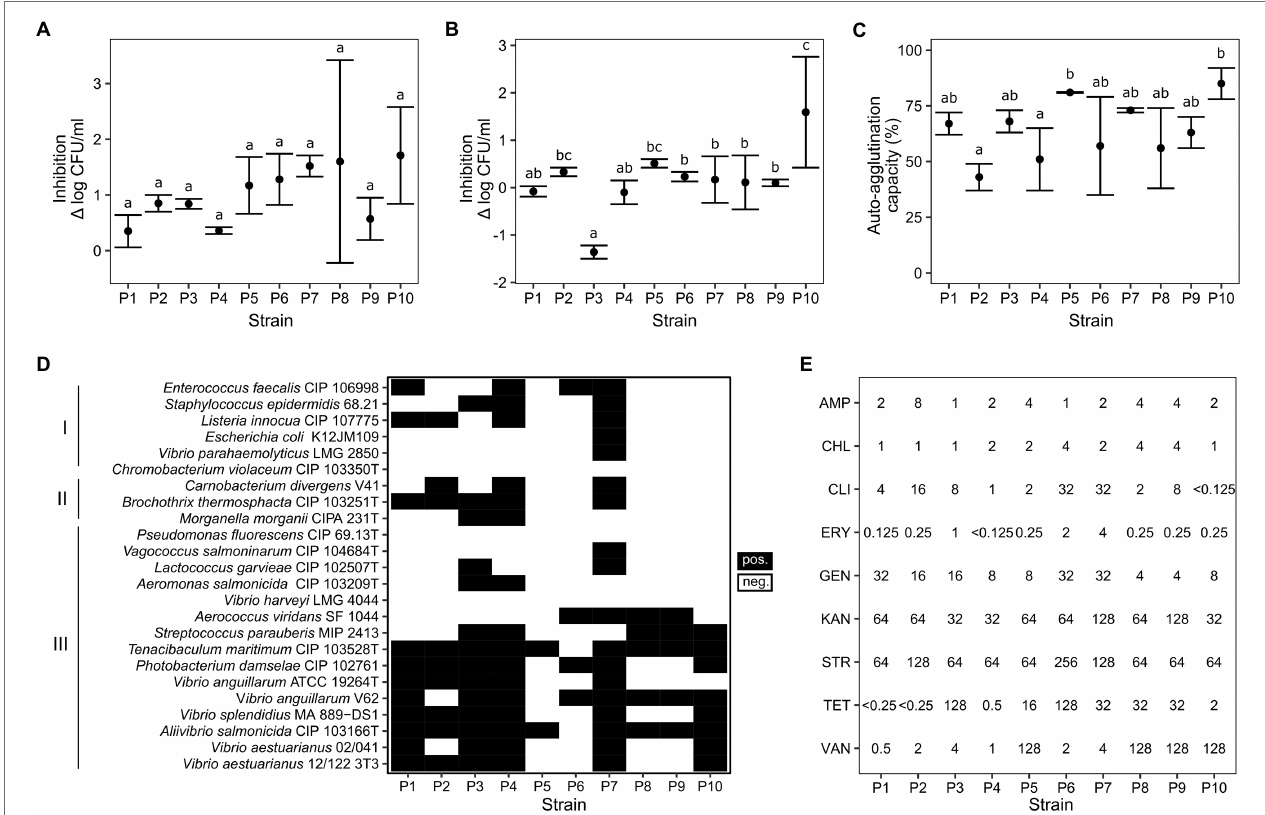
FIGURE 1 | Results of in vitro assays. (A) Survival in simulated gastric juice after 5 h (ANOVA: F (9, 20) = [1.58], p > 0.1); (B) Survival in bile acid after 24 h (ANOVA: F(9, 20) = [7.51], p < 0.001); (C) Auto-aggregation capacity (ANOVA: F(9, 20) = [4.37], p < 0.005); (D) Antimicrobial activity profiles against bacteria associated with human infection (I), seafood spoilage (II), and fish diseases (III). (E) Minimal inhibitory concentrations against nine antibiotics in μ g/ml (AMP: ampicillin, CHL: chloramphenicol, CLI: clindamycin, ERY: erythromycin, GEN: gentamicin, KAN: kanamycin, STR: streptomycin, TET: tetracycline, VAN: vancomycin). See selected EFSA cut-off values in Supplementary Table S3 . P1: Carnobacterium divergens ; P2: Carnobacterium maltaromaticum ; P3: Vagococcus fluvialis ; P4: Lactococcus lactis ; P5: Pediococcus acidilactici ; P6: Glutamicibacter bergerei ; P7: Enterococcus thailandicus ; P8: Lactiplantibacillus plantarum ; P9: Levilactobacillus brevis ; P10: Latilactobacillus sakei . Letters above error bars indicate significant differences ( p < 0.05) between samples based on Tukey’s HSD post-hoc